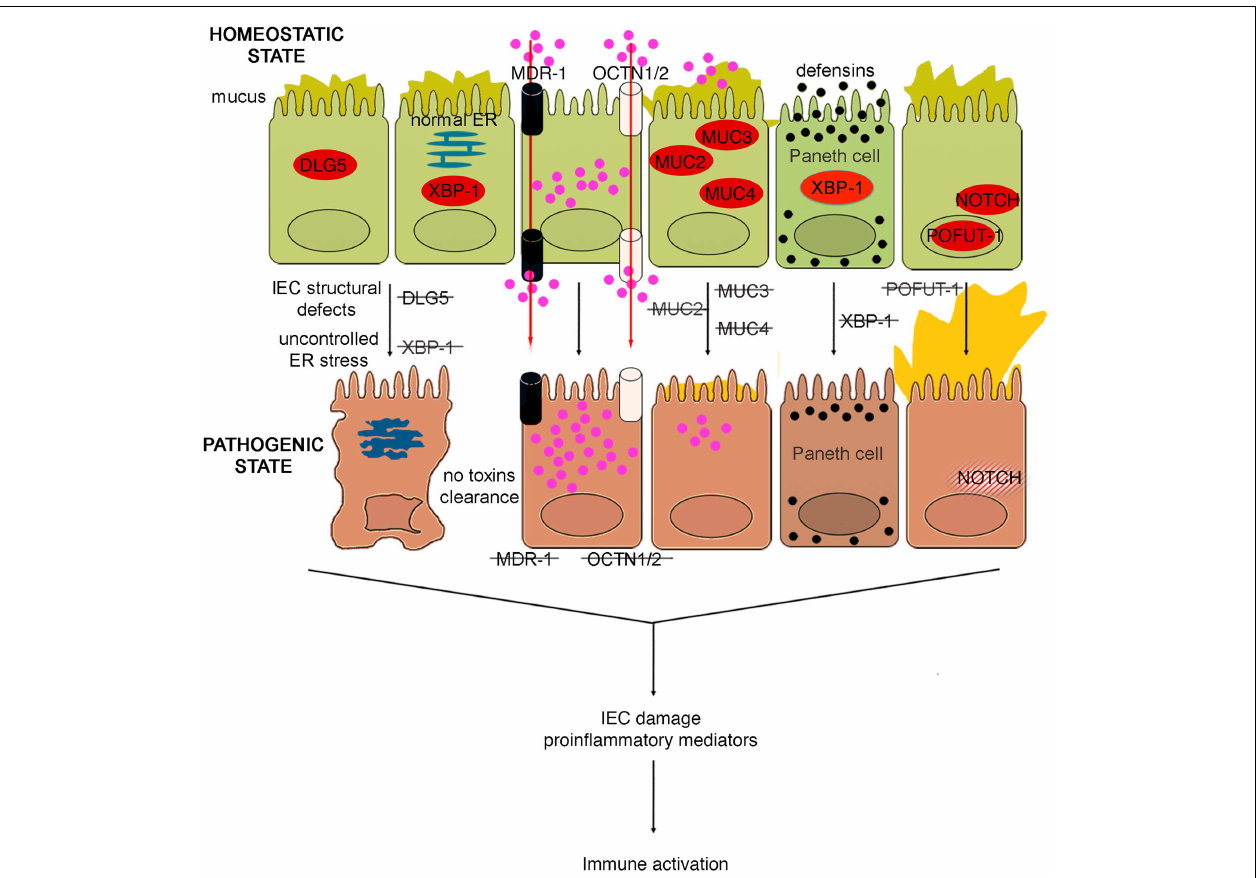
molecule loss of function, cause IEC damage, defective defensin secretion from Paneth cells, and release of proinflammatory mediators leading to immune activation. Direct exposure of IEC to luminal toxins/antigens is increased by deletion of MUC2, 3, and 4, which leads to dramatic reduction of mucus production, and eventually to intestinal inflammation. Conversely, overproduction of mucus is also harmful, leading to bacterial overgrowth in intestinal crypts, as seen in POFUT1 deficiency, causing a dysregulation of the epithelial transcription factor, NOTCH that controls IEC proliferation and